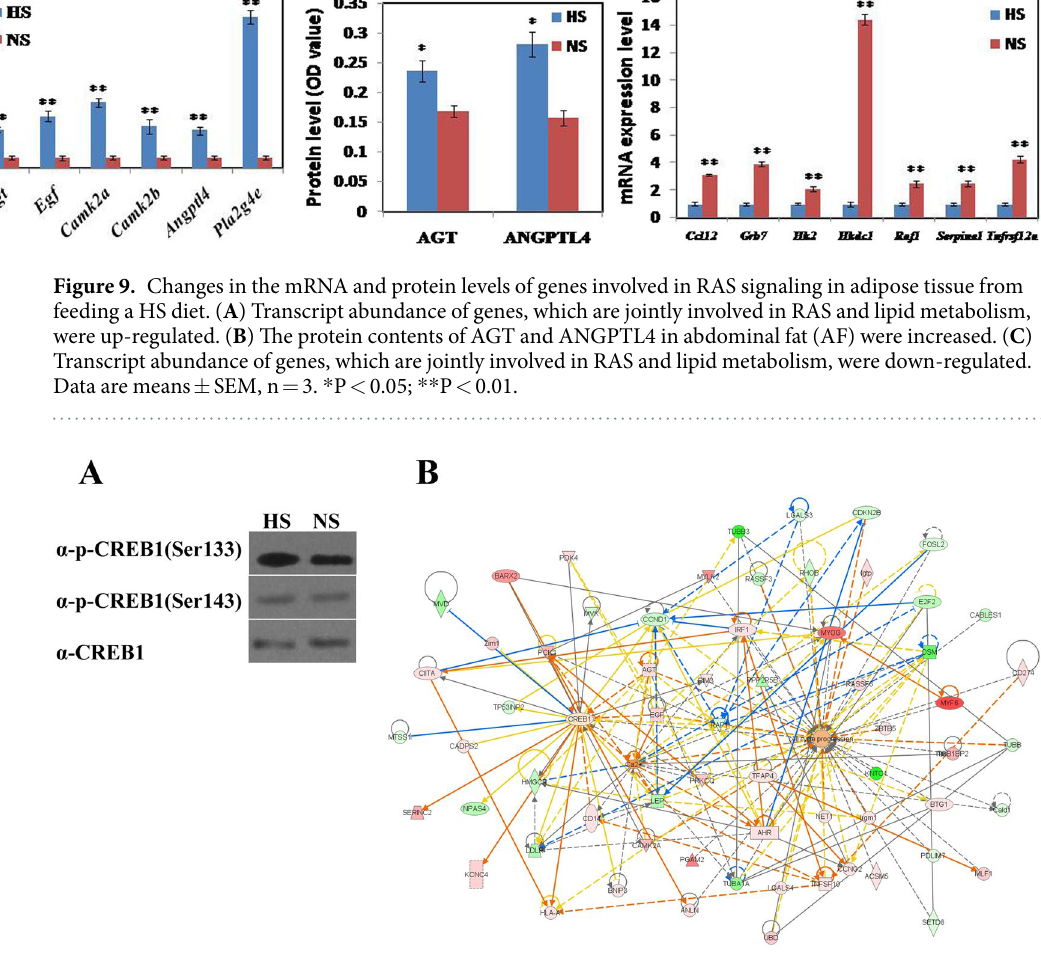
Figure 10. Phosphorylation of CREB1 protein ( A ) and the regulatory network based on calcium ion, CREB1 and DEGs by IPA software ( B